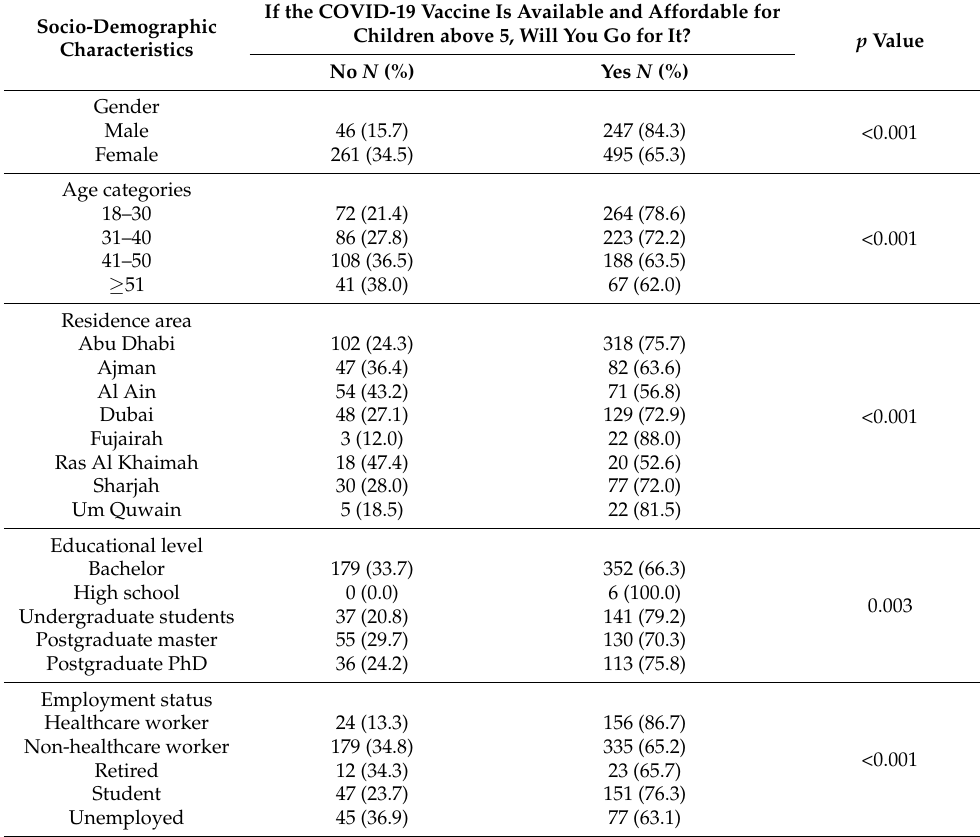
Table 3. Association between socio-demographic characteristics and parents’ acceptance of the COVID-19 vaccine ( n =